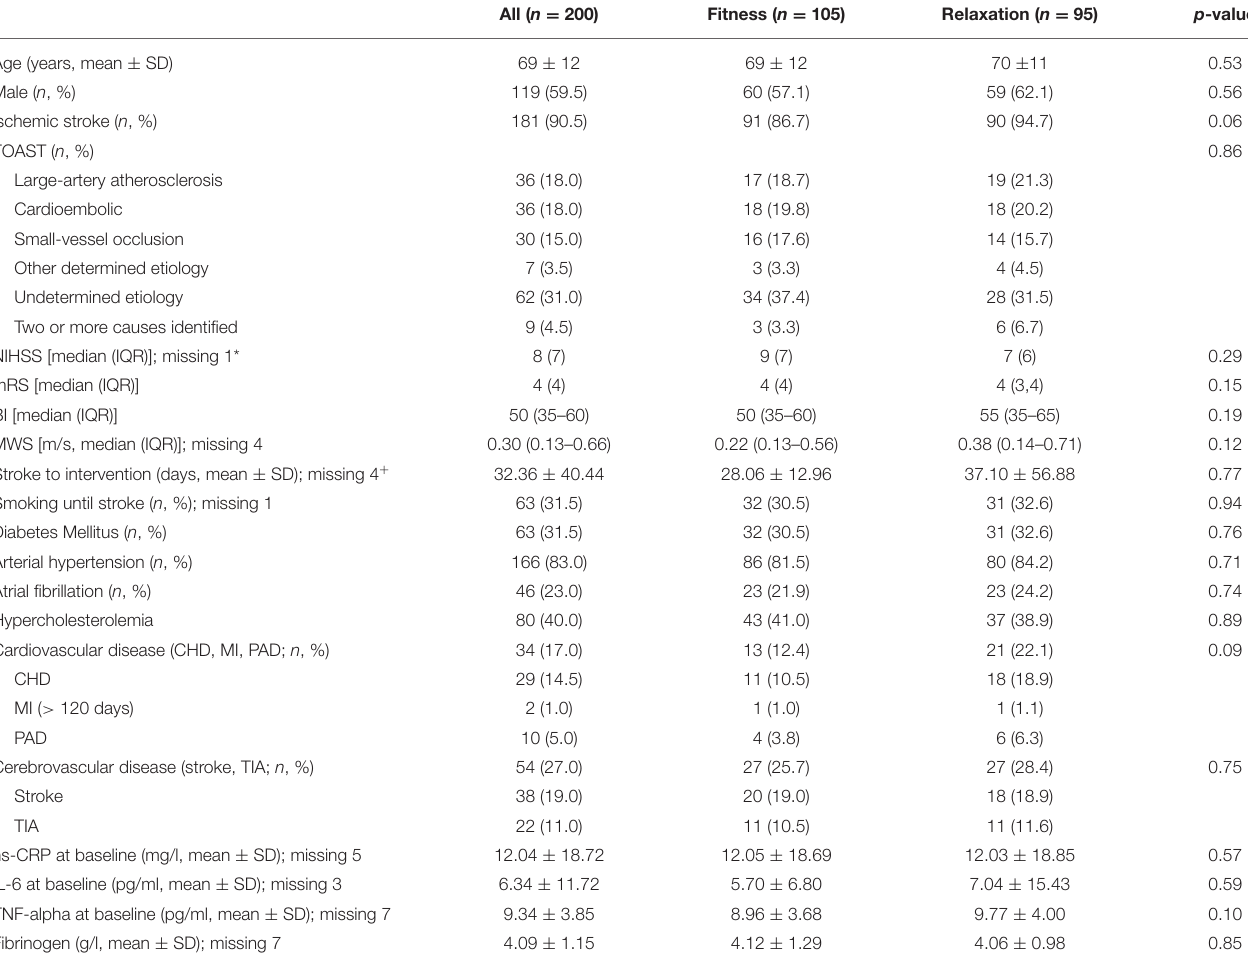
TABLE 1 | Baseline characteristics of the PHYS-STROKE